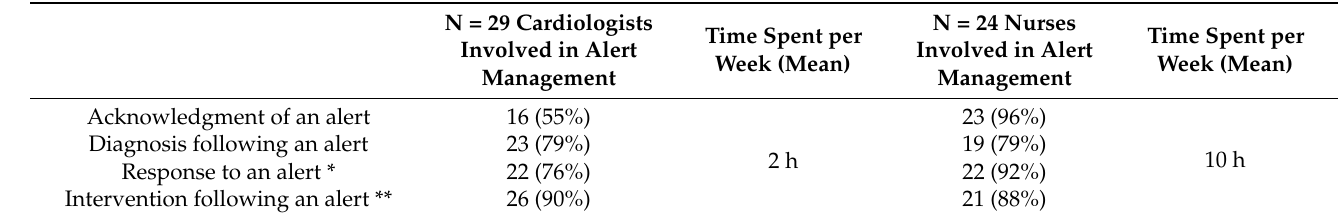
Table 3. Alert management tasks performed by healthcare professionals. N = 29